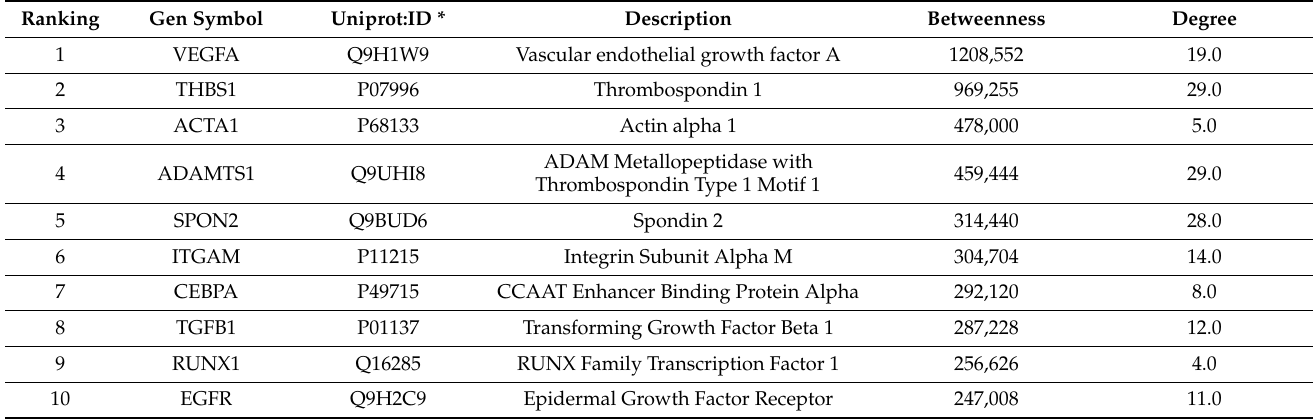
Table 2. PPI network centrality